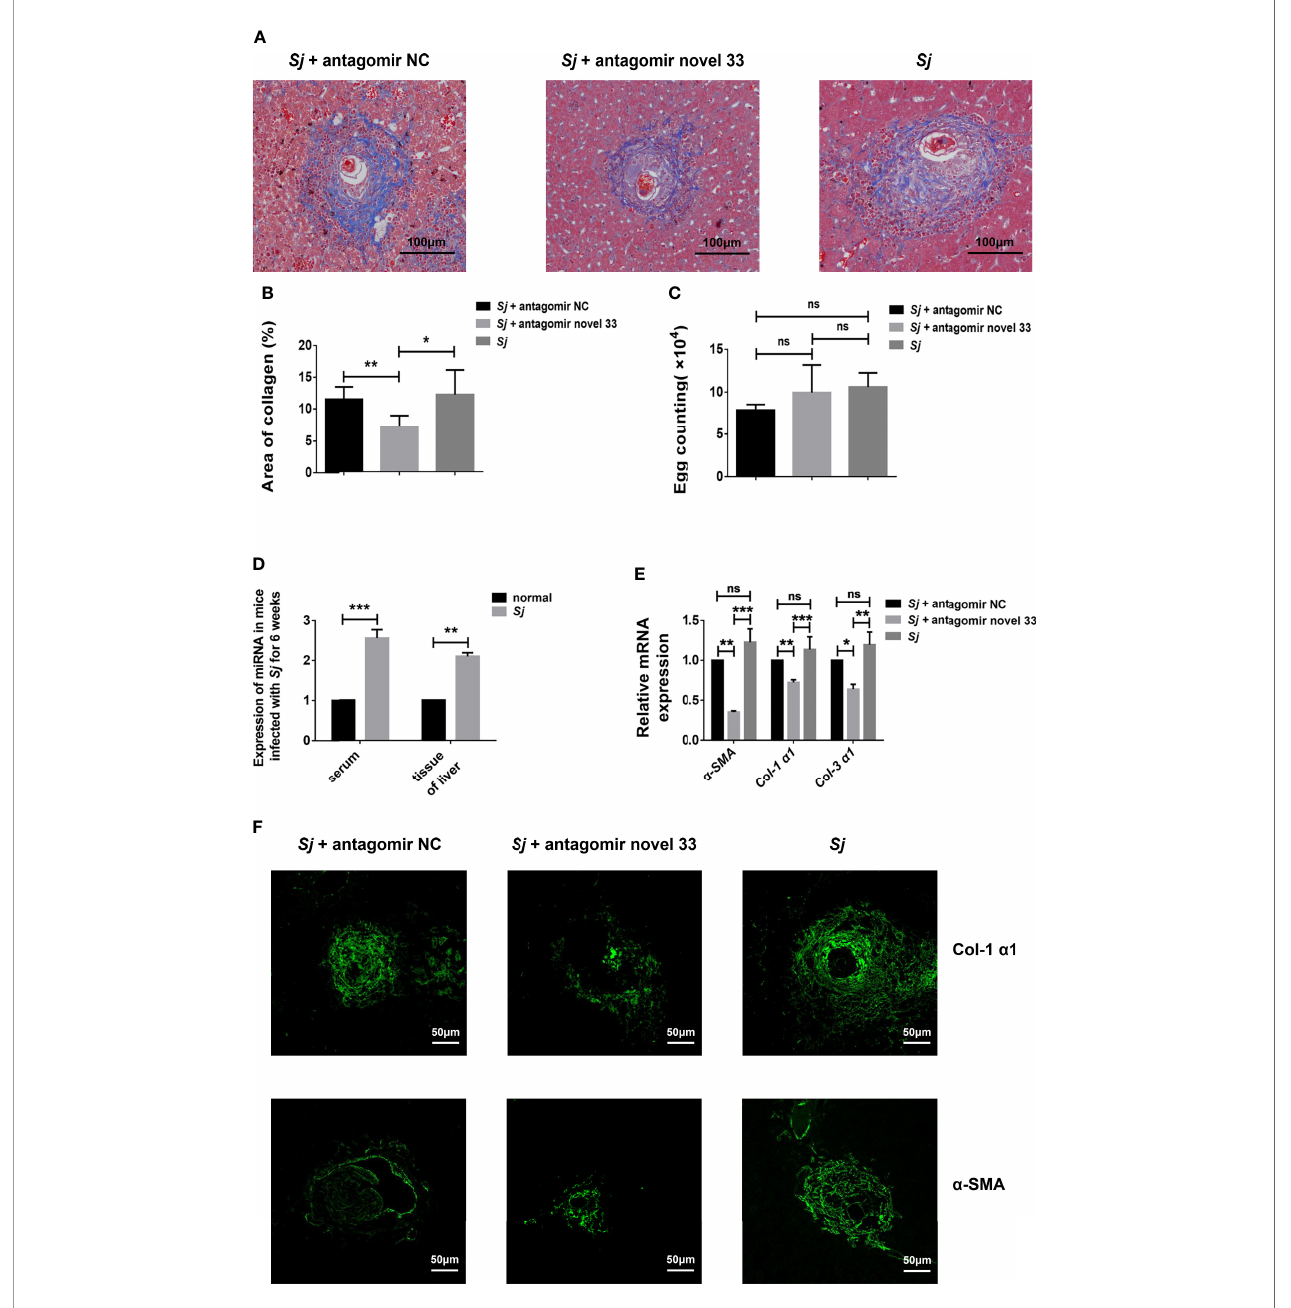
FIGURE 4 | Inhibition of novel miRNA-33 reduces the degree of liver fi brosis. Six-week-old female C57BL/6 mice were percutaneously exposed to 20 ± 1 S. japonicum cercariae, and 120 m L of 20 nM miRNA antagomir NC(Ribo), miRNA antagomir novel 33 (Ribo), or normal saline were injected via the tail vein 7 days after mice were infected with S. japonicum cercariae, once a week for 6 weeks. The magni fi cation of Masson-stained images is 10 ×, and the magni fi cation of immuno fl uorescence image is 20 ×. (A, B) Masson staining showing that areas of collagen were decreased after treatment with novel miRNA-33 antagomir. (C) Egg count in mouse liver tissue showing there was no statistical difference between the three groups. (D) Expression of novel miRNA-33 in mice infected with S. japonicum for 6 weeks. (E) qPCR results showing downregulation of a -SMA, Col 1 ( a 1), and Col 3 ( a 1) at the mRNA level. (F) Immuno fl uorescence images showing downregulation of type I collagen and a -SMA after treatment with antagomir. mRNA expression levels of a -SMA , Col 1 ( a 1) , and Col 3 ( a 1) were normalized agaisnt GAPDH , and expression of novel miRNA-33 was normalized against U6. Results are averaged from three independent experiments, Student ’ s t -tests were applied to assess differences between two groups, and one-way analysis of variance (ANOVA) followed by Tukey ’ s post-tests was used for three or more groups ( fl uorescence is SpGreen; n = 20; * p < 0.05, ** p < 0.001, *** p < 0.0005; NS, not signi fi